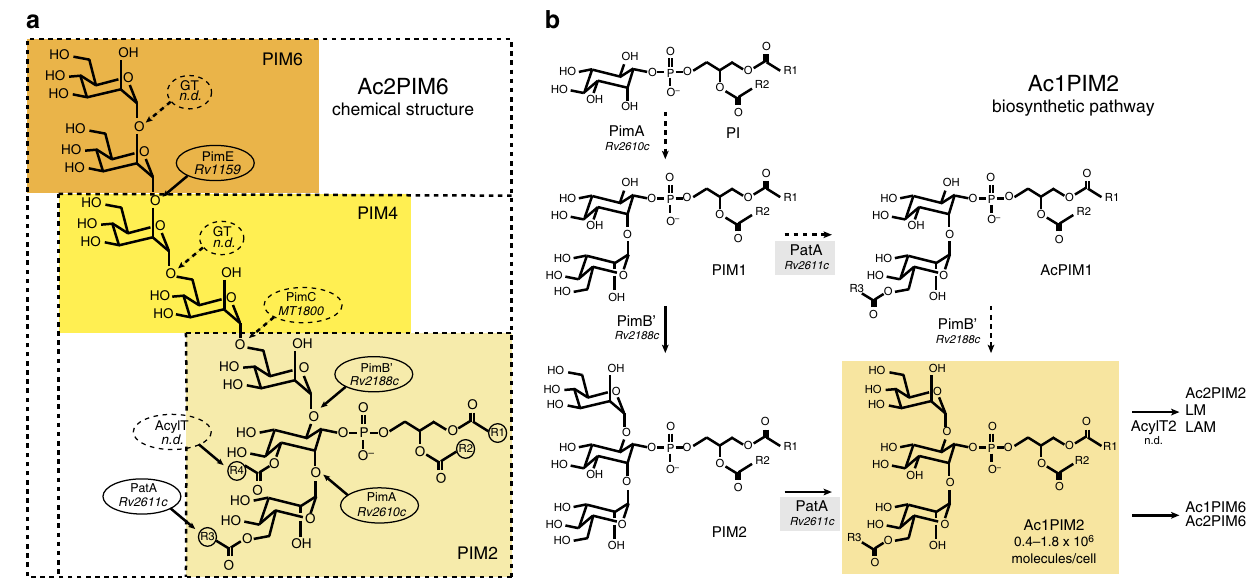
Figure 1 | Proposed pathway for the early steps of PIM biosynthesis in mycobacteria. ( a ) Chemical structure of PIM 2/6 and their acylated forms Ac 1/2 PIM 2 and Ac 1/2 PIM 6 . ( b ) The two pathways originally proposed for the biosynthesis of Ac 1 PIM 2 in mycobacteria are shown: (i) PI is mannosylated to form PIM 1 . PIM 1 is then mannosylated to PIM 2 , which is acylated to form Ac 1 PIM 2 ; (ii) PIM 1 is first acylated to Ac 1 PIM 1 and then mannosylated to Ac 1 PIM 2 . Our experimental evidence indicates that although both pathways might co-exist in mycobacteria, the sequence of events PI - PIM 1 - PIM 2 - Ac 1 PIM 2 is favoured. As an important part of the literature concerning PIMs studies refers to the nomenclature based on the Mtb H37Rv sequences, we also include the Rv numbers to identify the